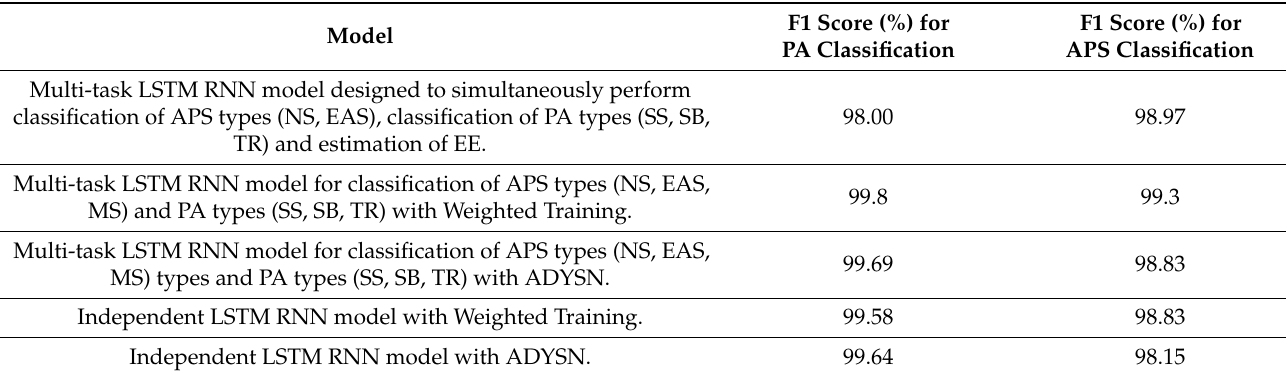
Table 6. F1-score for PA and APS Classification (LSTM RNN models). Model